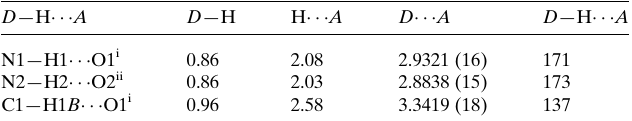
Table 1 Hydrogen-bond geometry (A˚ , (cid:2) ).